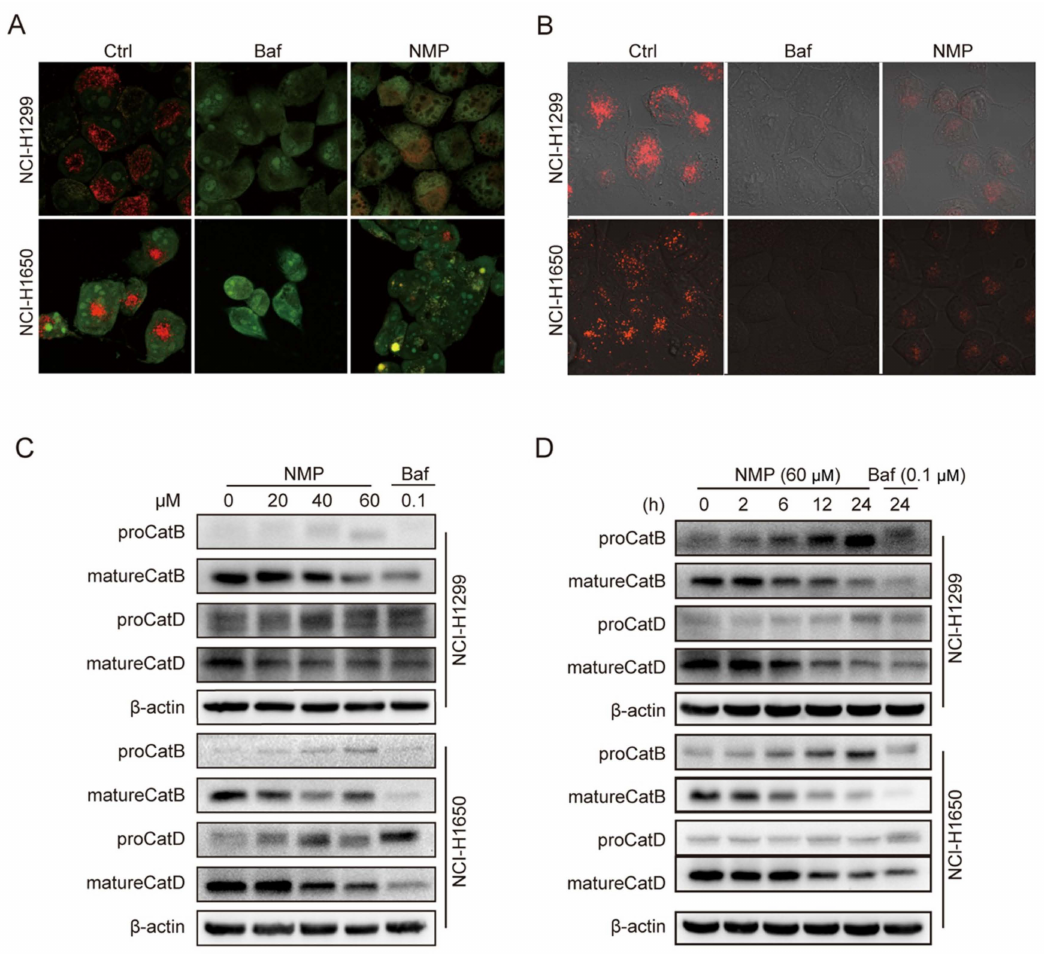
Figure 8. NMP altered lysosomal pH and inhibited lysosomal cathepsins maturation. ( A , B ) Typical fluorescence micrograph of vehicle-, Baf (0.1 µ M)- or NMP (40 µ M)-treated NCI-H1299 and NCI-H1650 cells subjected to pH-dependent fluorescent dyes acridine orange (AO) and Lysotracker Red DND-99 stainings to detect lysosomal acidification. Scale bar, 20 µ m. ( C , D ) Western blot analysis for mature cathepsin B and D detection in treated cells in dose- ( C ) or time-dependent manners ( D